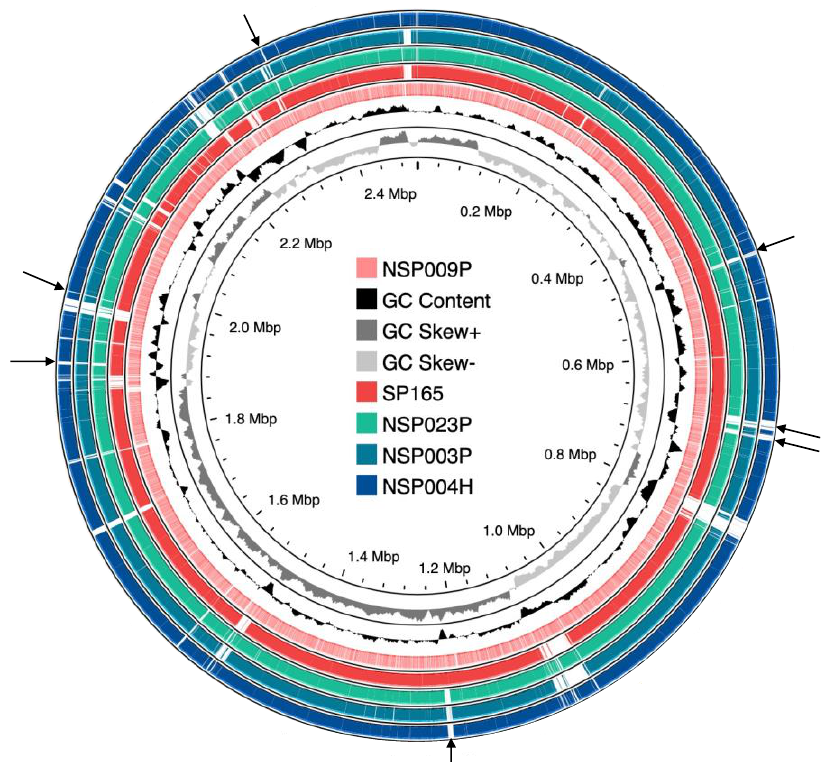
Figure 5. Sequences comparison of S. pettenkoferi genomes. The NSP009P strain was compared against SP165 (a virulent strain) and the NSP003P, NSP023P and NSP004H genomes. The inner light red ring represents the NSP009P genome; the middle red one shows the SP165 genome after BLASTn match; while the outer green, light blue and dark blue rings correspond to NSP023P, NSP003P and NSP004H, respectively. Missing regions identified by the BLAST analysis on the CGView server’s PROKSEE software are shown as ‘gaps’ on each of the circular genomes. Arrows represent regions shared between SP165 and NSP009P but not present in the NSP023P, NSP003P and NSP004H genomes. The inner ring corresponds to the GC skew of S. pettenkoferi NSP009P isolate. Light grey profile indicates overabundance of GC nucleotides, whereas dark grey shows the opposite. The inner black ring represents the GC%.